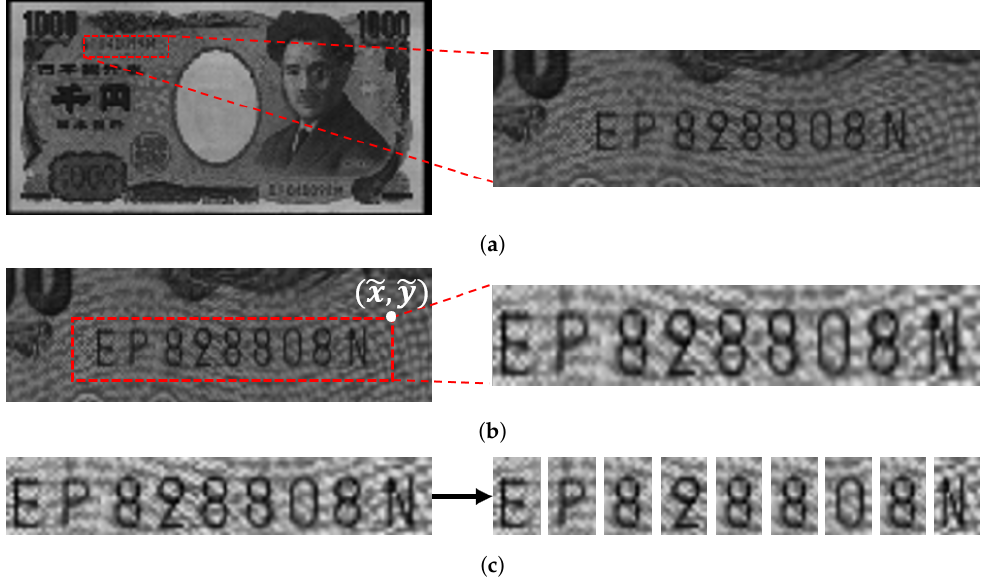
Figure 1. Images of Japanese Yen and their cropped image. ( a ) Region detection ( b ) ROI detection ( c ) Character classification.